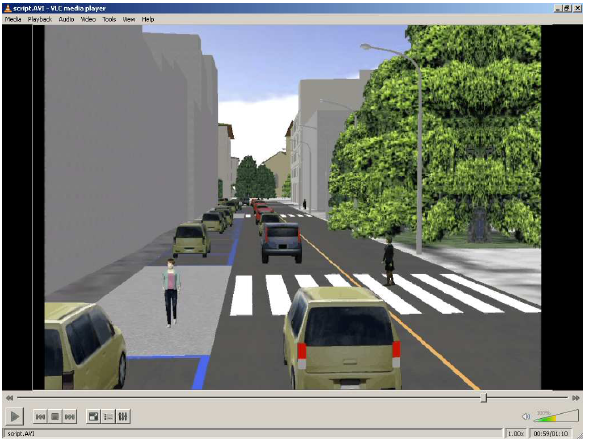
Figure 13. Flows people interaction in the architectural space